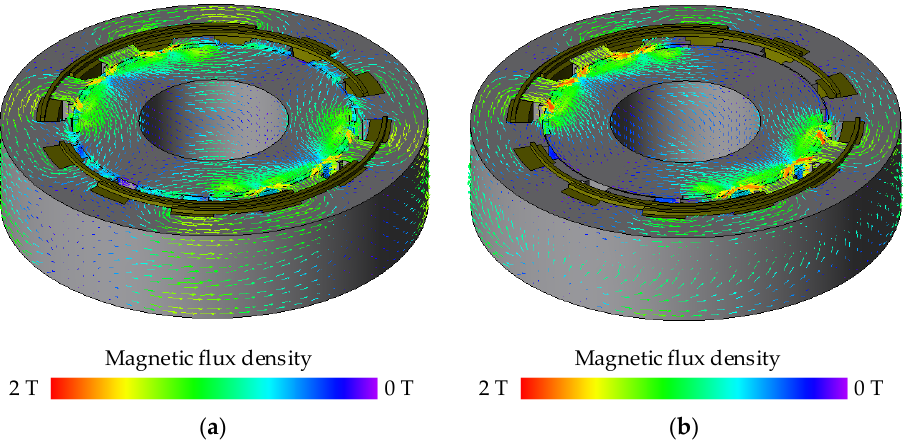
Figure 10. Magnetic vector plot of CPPM machine. ( a ) With 10A field current. ( b ) With − 10A field current.